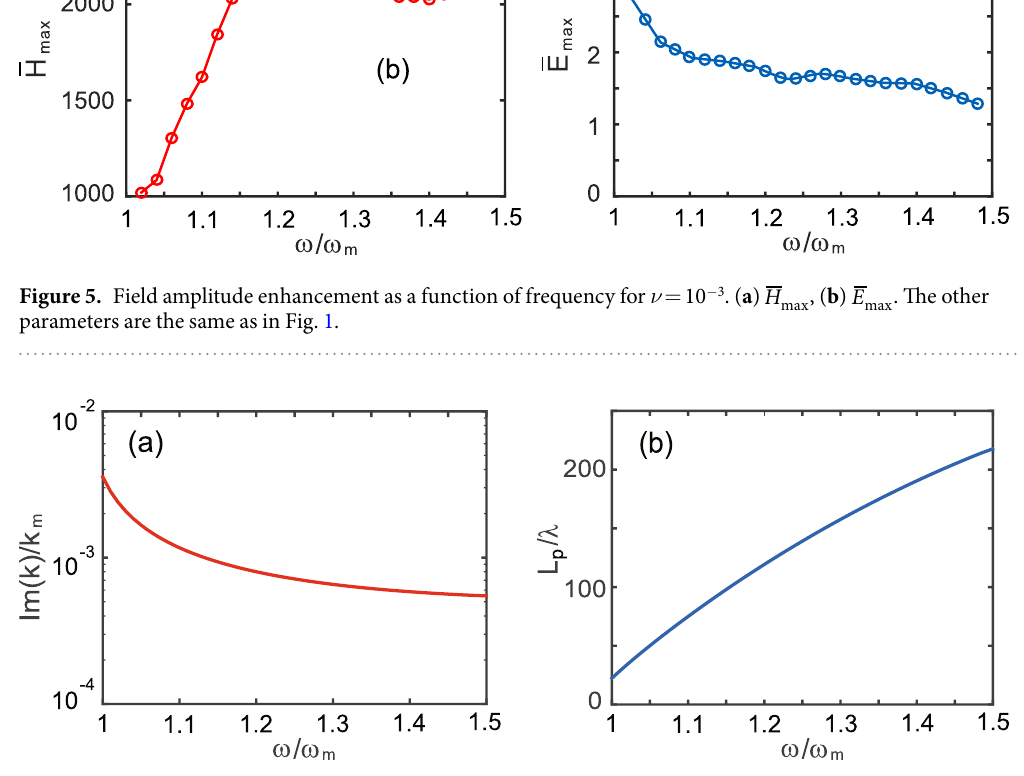
Figure 6. Imaginary part of propagation constant ( a ) and related propagation length ( b ) as a function of frequency for ν = 10 − 4 . The other parameters are the same as in Fig.